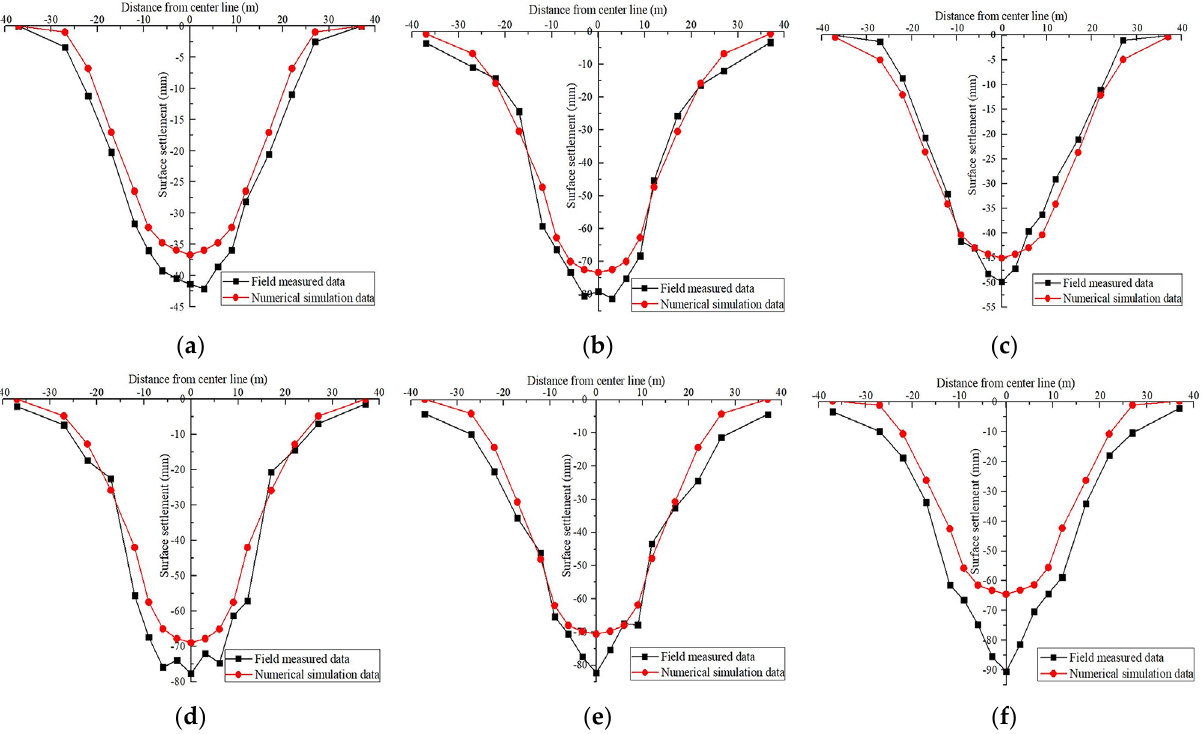
Figure 14. Comparison of simulated and measured ground subsidence at various construction stages: Completion of ( a ) pilot tunnel construction, ( b ) pile-beam construction, ( c ) first lining of the arch construction, ( d ) second lining of the arch construction, ( e ) station hall construction and ( f ) platform layer construction.